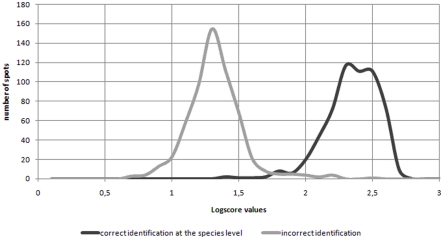
Distribution of the best-match LS values recorded during the mass spectra library validation test.The figure shows the best-match LS values for each of the 4 spots issued from a subculture of the 146 strains included in the library. The dark line represents the best-match LS values of the correct identification results whereas the gray line shows the best-match LS values of the misidentification results. The distributions of the best-match LS values for the spectra resulting either in a correct identification or a misidentification did almost not overlap.